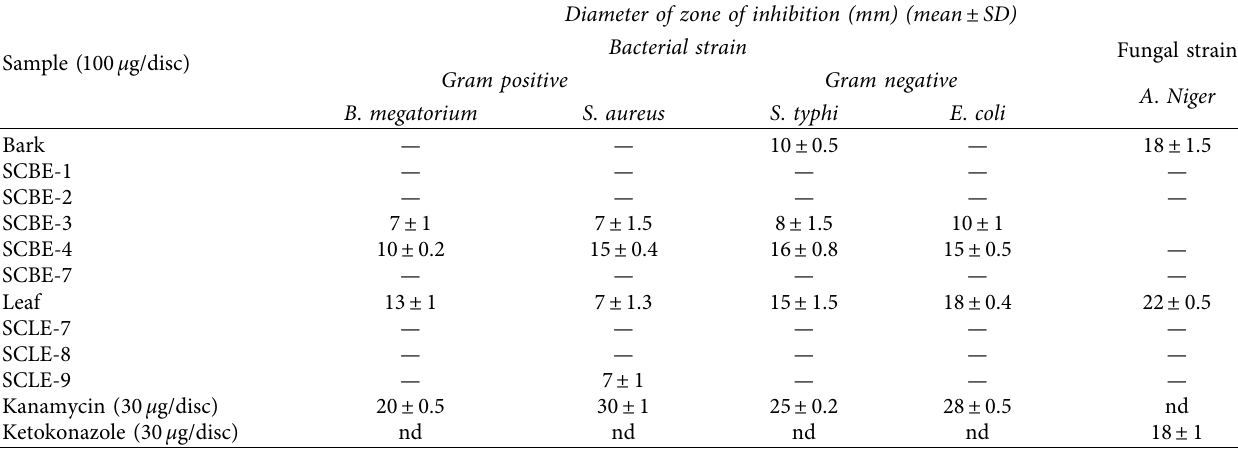
Table 3: Antimicrobial activity of plant extracts and endophytic fungal